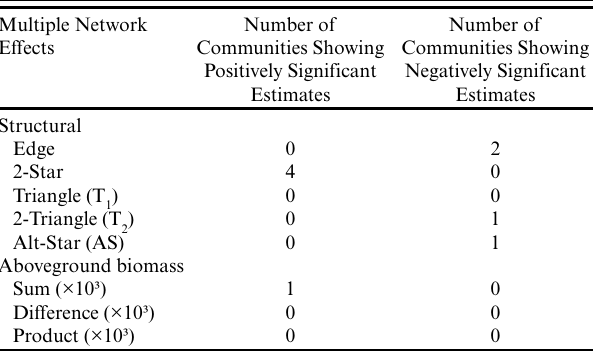
Table 6 . Exponential random graph model (ERGM) positive and negative significant